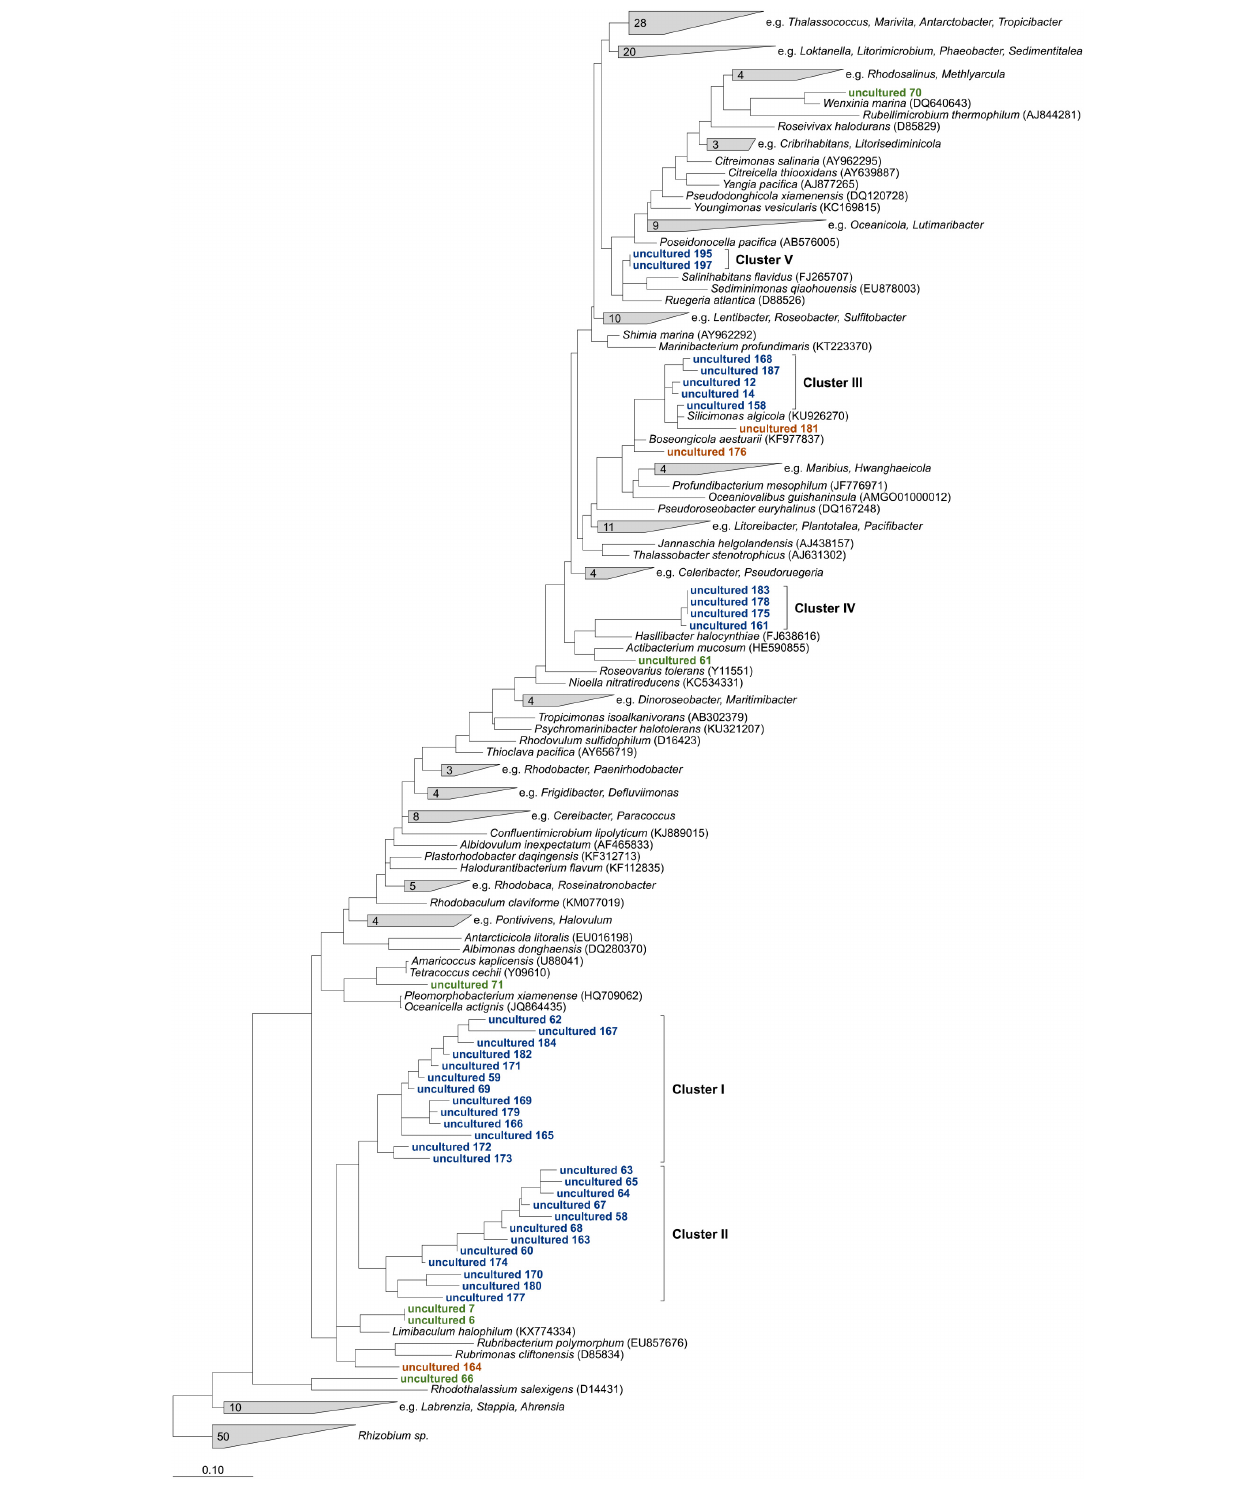
Frontiers in Microbiology |